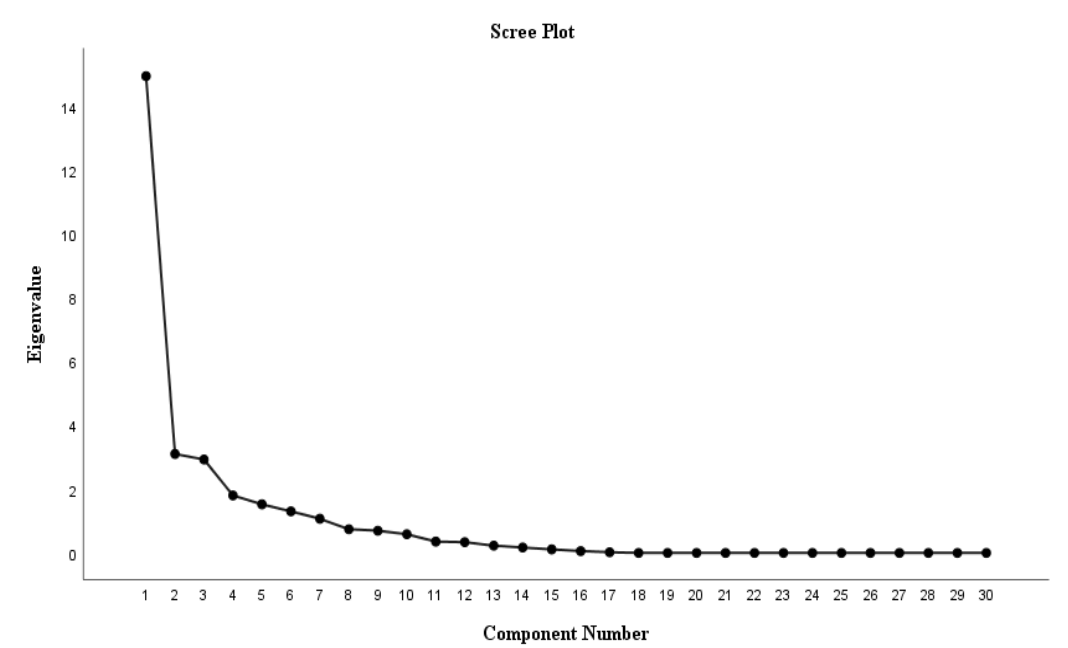
Fig. 3. Scree plot of morphometric analysis: This analysis between N. complanata and N. crispa ; Scree plot that showed first components with the most variance; The four first components in this graph represent the highest variance of the total variance; Four first component has a 75.968 % variance in this chart.